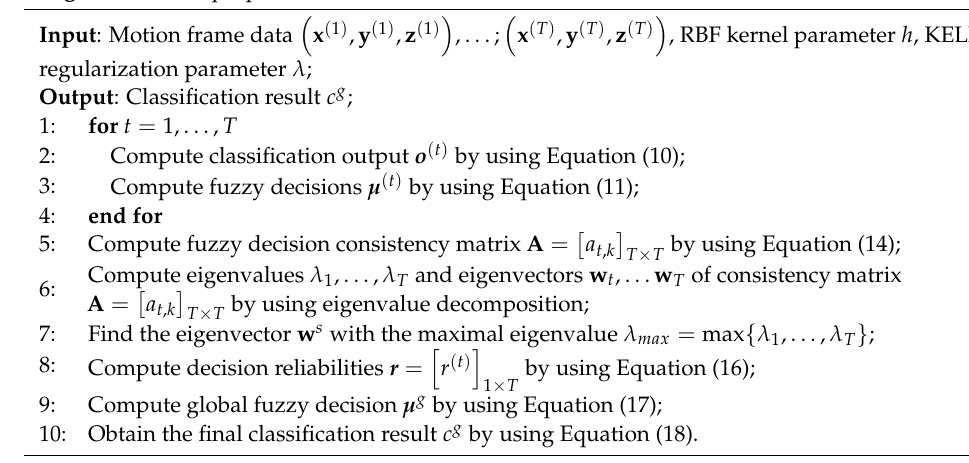
Algorithm 1 The proposed RWS decision fusion